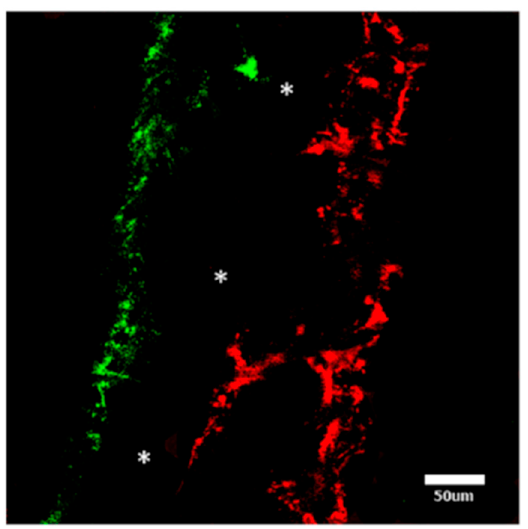
Figure 4. Tri-layer scaffold after 28 days culture, showing HDFs (green) and matrix mineralization by hBMSCs (red), with the nanofibre layer as an unstained region (white asterisks) in the center (scale bar = 50 µm).